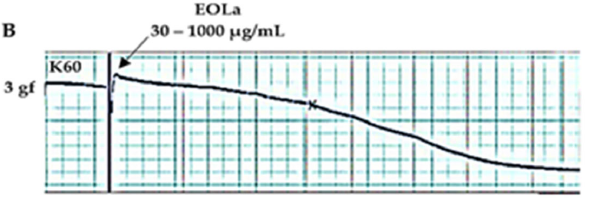
Figure 2. Relaxing effect of EOLa and evaluation of K60 electromechanical coupling in HUA. ( A ) “Log-normal” plot for EOLa (30–1000 µ g/mL) on contractions induced by potassium chloride in HUA; values are expressed as the mean ± SEM; n = 6 ( p < 0.017, one-way ANOVA). ( B ) Original registration made by the LabChart Pro software for the relaxing effect of EOLa on the electromechanical coupling induced by K60 in HUA.